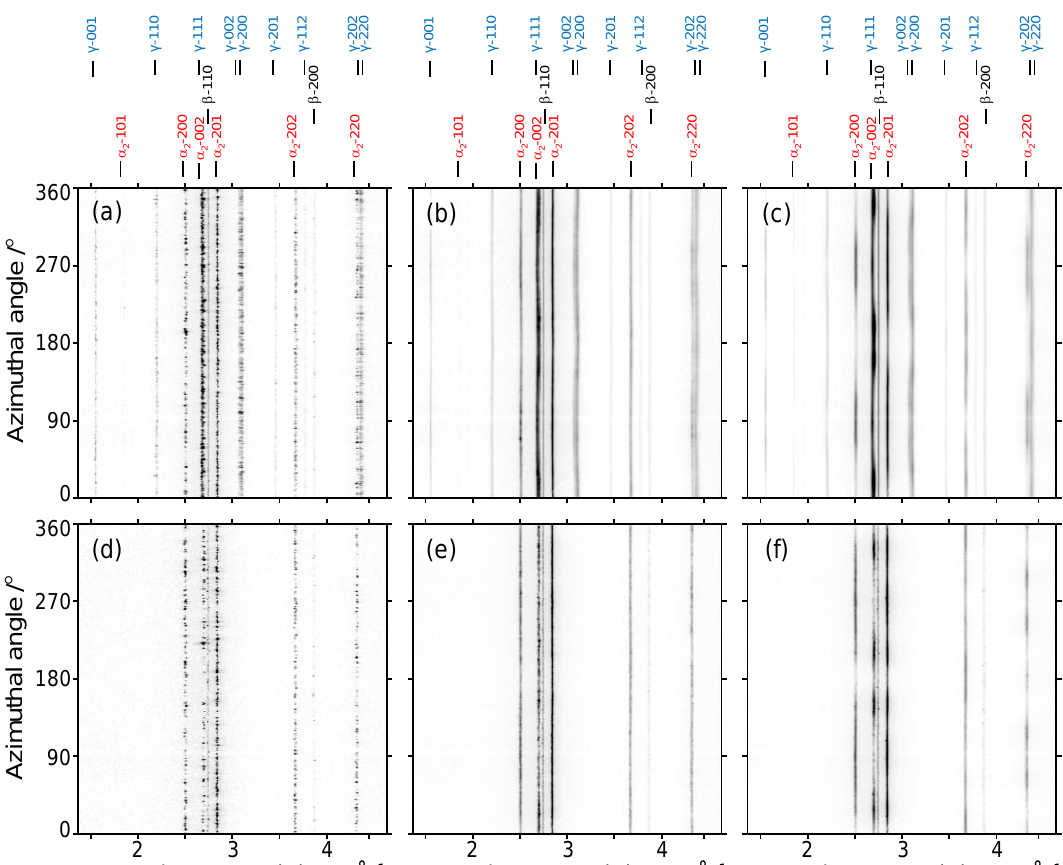
Figure 4. Unrolled diffraction rings taken during two hot forming experiments at ( a – c ) 1150 °C; ( d – f ) 1250 °C; ( a , d ) before deformation; ( b , e ) after 10%; and ( c , f ) after 30% deformation. The reflections of the various phases are indicated at the top of the